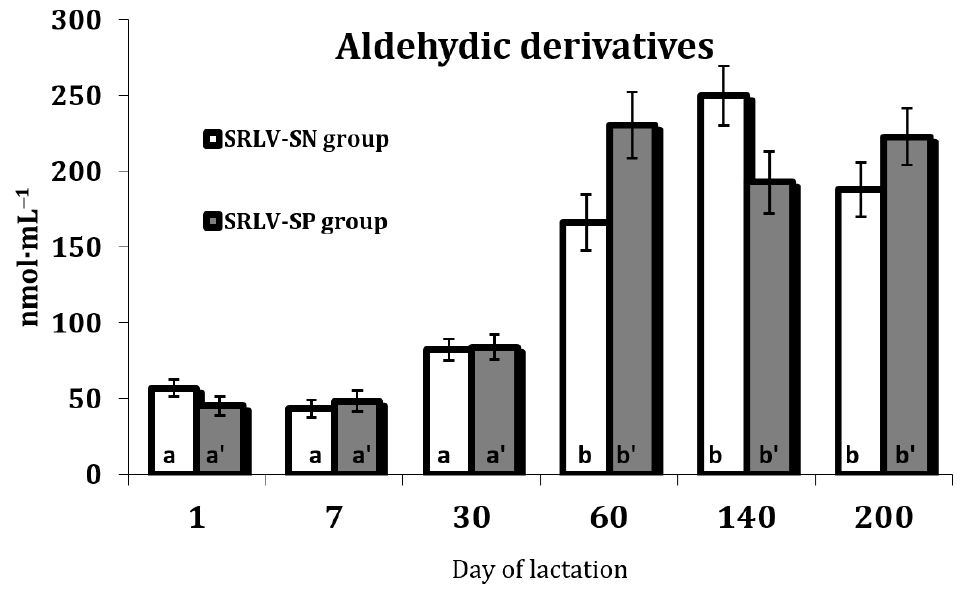
Figure 3. Aldehydic derivatives of oxidatively modified proteins (nmol · mL − 1 ) in the serum of SRLV-SN and SRLV-SP goats during lactation. Values are expressed as means ± SEM; a, b—different letters indicate significant differences between stages of lactation within the SRLV-SN group at p < 0.05; a’, b’—different letters indicate significant differences between stages of lactation within the SRLV-SP group at p < 0.05; SRLV-SP—small ruminant lentivirus seropositive goats; SRLV-SN—small ruminant lentivirus seronegative goats.